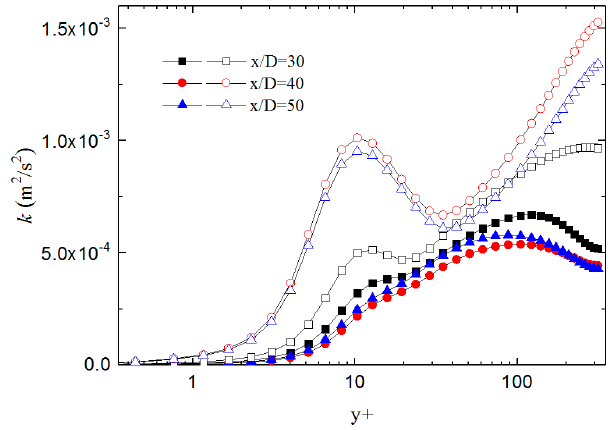
Figure 11. Comparison of turbulent kinetic energy in a different location (Solid: C2; Hollow: D2).